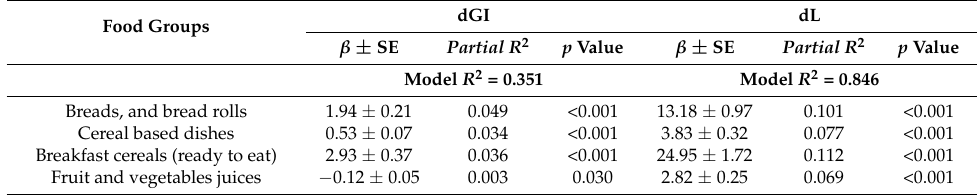
Table 7. The contribution of the top 20 GL food groups to inter-individual variations in dietary glycaemic index (dGI) and glycaemic load (dGL) in 2012NS ( n =